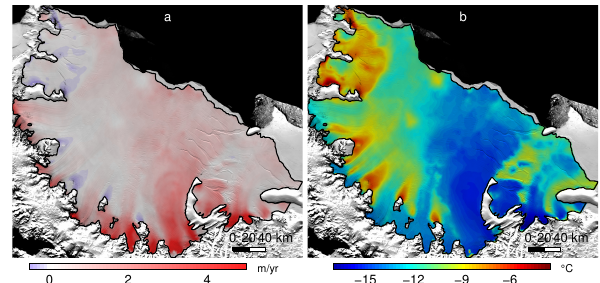
Fig. 2. (a) Ratio α = ˙ ε yy / ˙ ε xx between lateral and longitudinal strain rate; (b) and ratio β = ˙ ε xy / ˙ ε xx between shear and longitu- dinal strain rate. For both plots the x axis is defined along the flow using the observed velocity components. Both panels plotted over 2009 MOA image.